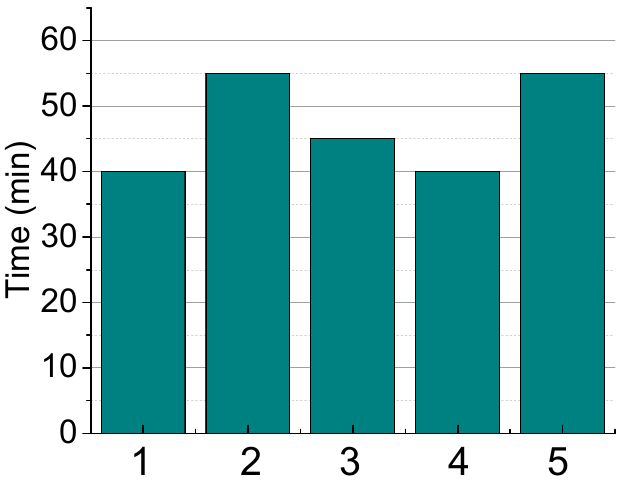
Figure 8. Time needed to reach 100% of MB removal using five different electrodes prepared with methodology A. T 25 °C, I = 100 mA.